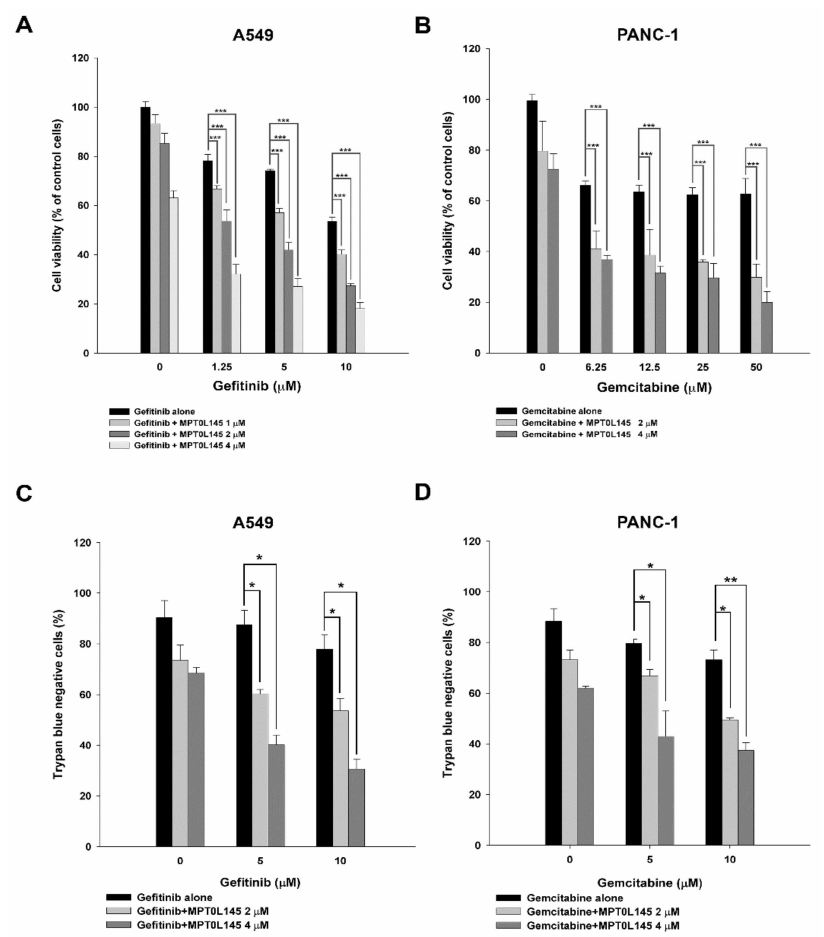
Figure 2. MPT0L145 sensitized cancer cells to targeted or chemotherapeutic agents. ( A , C ) A549 cells were treated with indicated concentrations of gefitinib in the absence or presence of MPT0L145 for 72 h and subjected to MTT assay ( A ) or trypan blue exclusion assay ( C ). Data are expressed as means ± S.D. ( N = 3, * p < 0.05, *** p < 0.001 compared to gefitinib alone). ( B , D ) PANC-1 cells were treated with indicated concentrations of gemcitabine in the absence or presence of MPT0L145 for 72 h and subjected to MTT assay ( B ) or trypan blue exclusion assay ( D ). Data are expressed as means ± S.D. ( N = 3, * p < 0.05, ** p < 0.01, *** p < 0.001 compared to gemcitabine